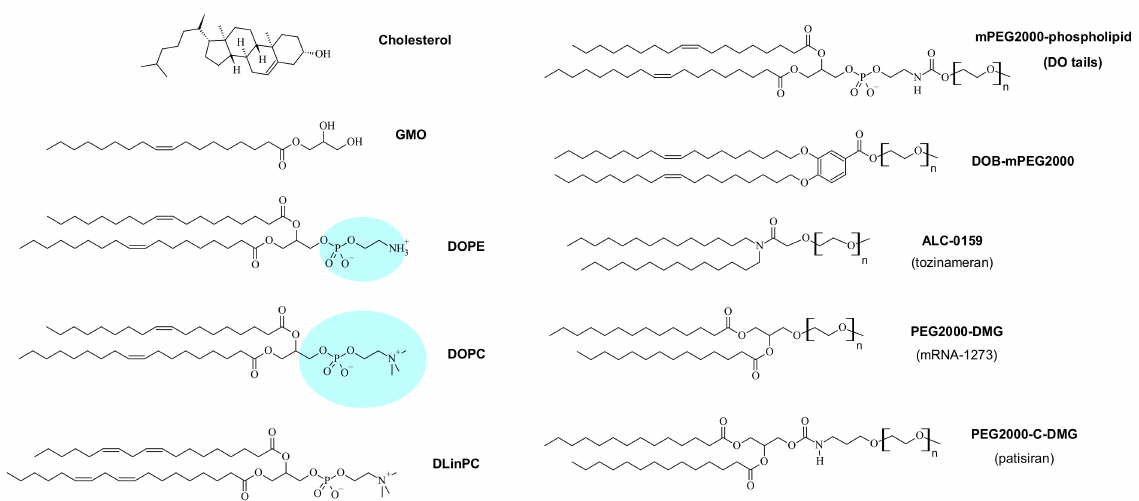
Figure 3. Structures of selected neutral (“helper”) lipids and PEG-lipids used in CL-based NA vectors. The molecular weight of the PEG chain of all depicted lipids is 2000 g/mol ( n = 45). The phospholipids DOPC, DOPE, and DLinPC are zwitterionic, while GMO and cholesterol are uncharged. The blue highlighting represents the large difference in hydration for DOPE and DOPC. DLinPC: 1,2-dilinoleoyl- sn -glycero-phosphocholine; DO: dioleoyl; DOPC: 1,2-dioleoyl- sn -glycero-phosphocholine; DOPE: 1,2-dioleoyl- sn -glycero-phosphoethanolamine; GMO: glycerol